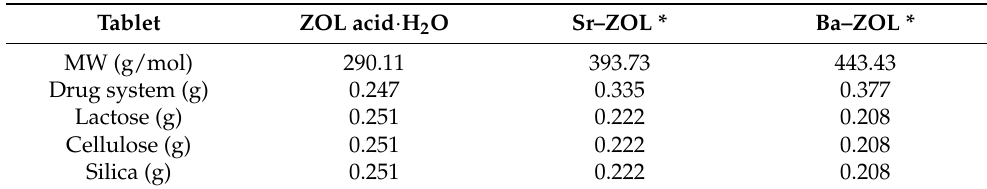
Quantities of active agents (free ZOL or metal–ZOL) and excipients utilized for tablet